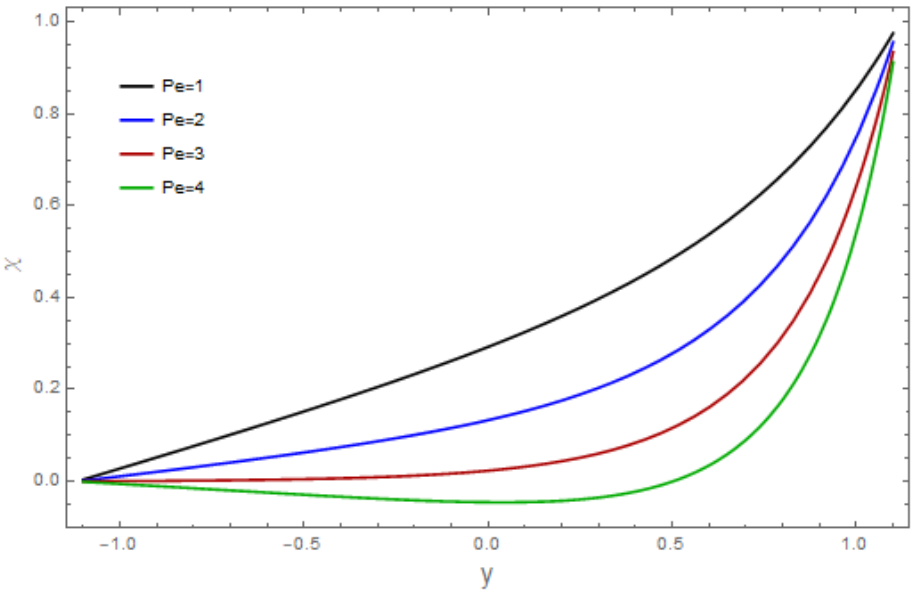
Figure 18. Effect of 𝑃𝑒 on 𝜒 .